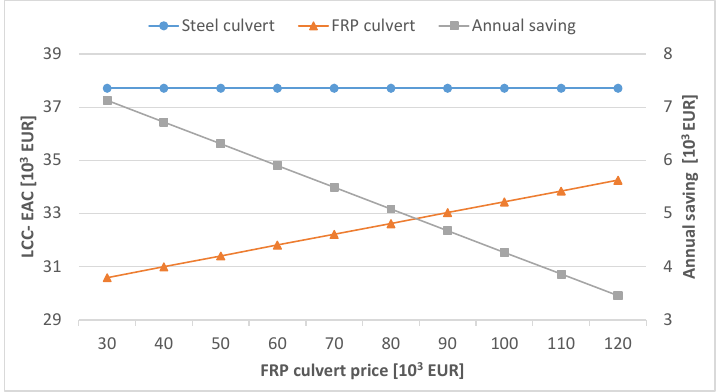
Figure 15. Impact of the FRP culvert structure price on the LCC and annual saving.